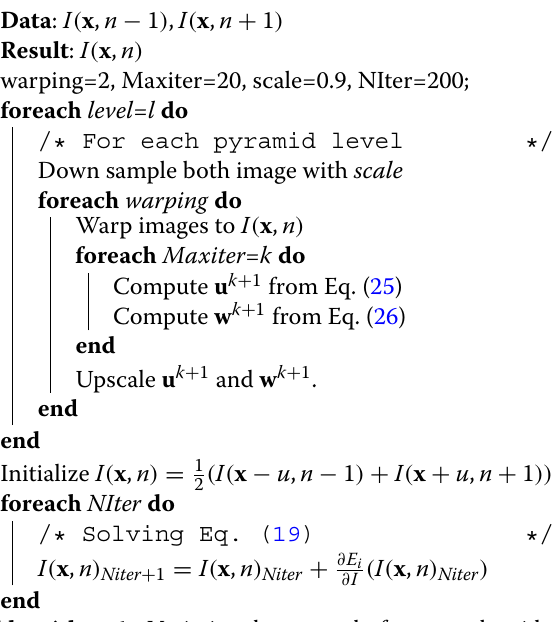
Algorithm 1: Variational approach for capsule video frame